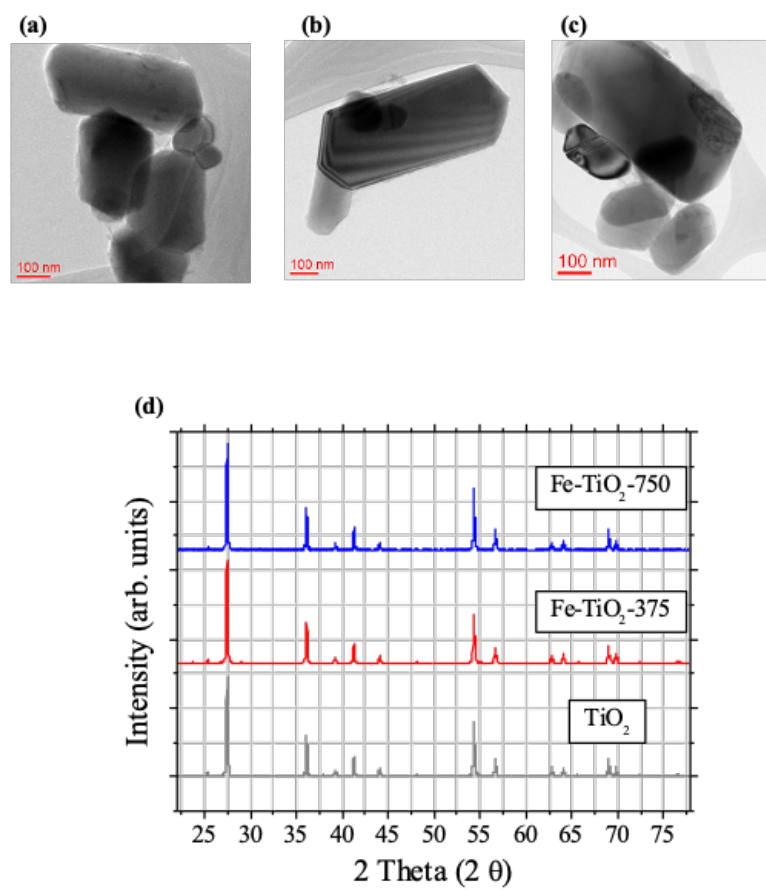
Figure 1. Characterization results for TiO 2 , Fe-TiO 2 -375, and Fe-TiO 2 -750 particles. TEM images of ( a ) TiO 2 , ( b ) Fe-TiO 2 -375, and ( c ) Fe-TiO 2 -750 particles. ( d ) XRD patterns of TiO 2 , Fe-TiO 2 -375, and Fe-TiO 2 -750 particles (XRD patterns of all the synthesized samples are provided in Supporting information). Table 1. The specific Brunauer–Emmett–Teller (BET) surface areas of TiO 2 , Fe-TiO 2 -375, and Fe-TiO 2 - 750 particles (the specific BET surface areas of all the synthesized samples are provided in Supporting